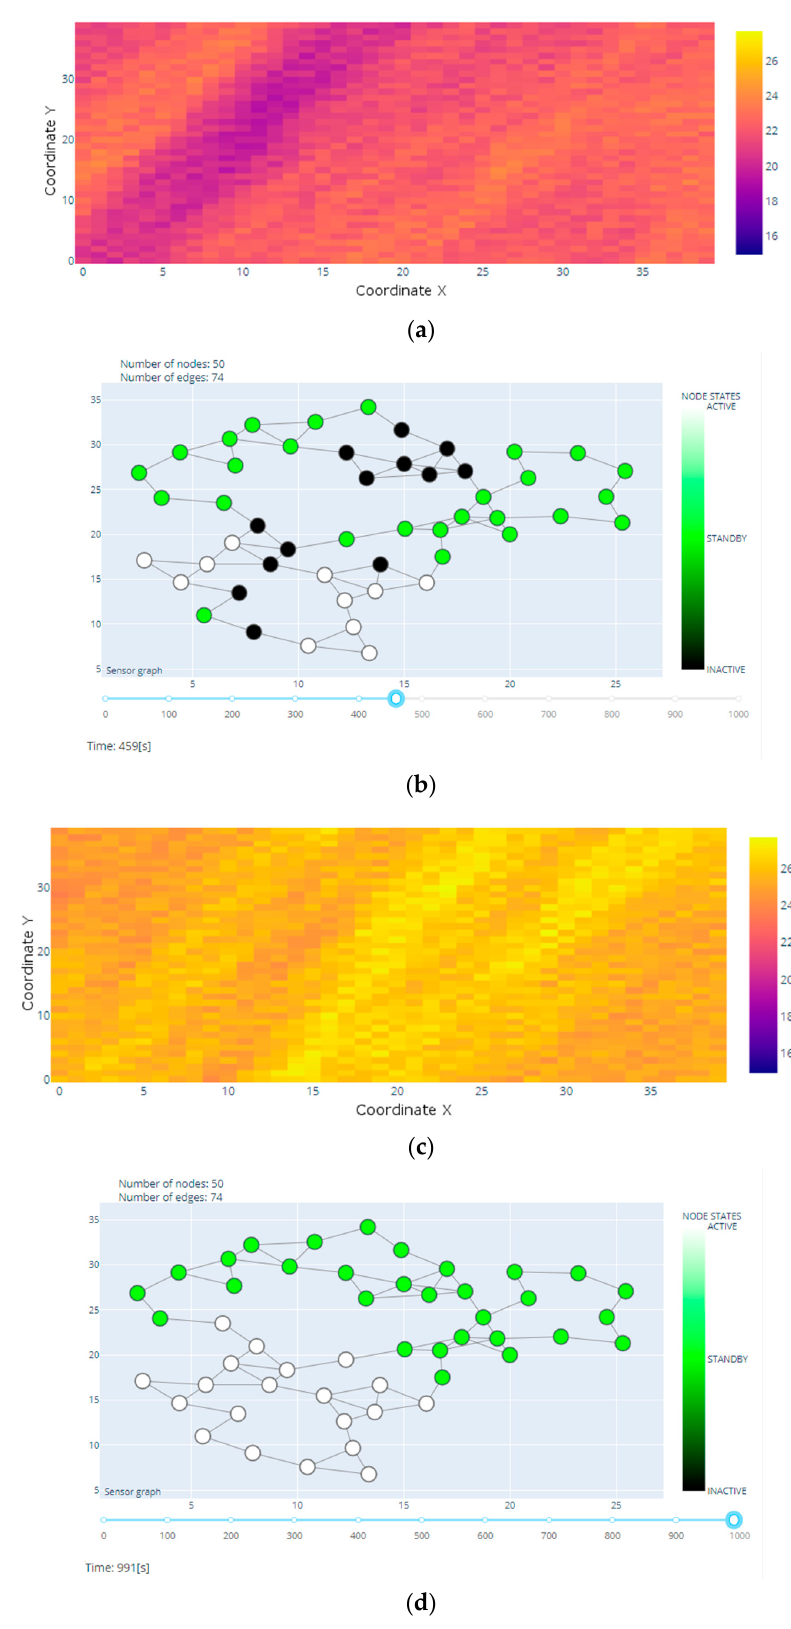
Figure 5. Selected steps of the simulation; ( a ) heat map in 459 s; ( b ) states of individual nodes in 459 s; ( c ) heat map in 991 s; ( d ) states of individual nodes in 991